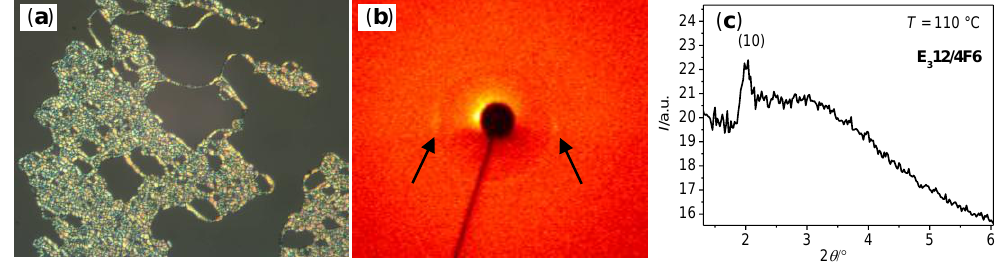
Figure 13. Investigation of the SmA+ phase of compound E 3 12/4F6 . ( a ) Oily streaks texture with dark homeotropic areas as observed between crossed polarizers at T = 130 °C; ( b ) SAXS pattern of an aligned sample at T = 110 °C (arrows indicate the weak layer reflections); and ( c ) 2 θ scan over this pattern.